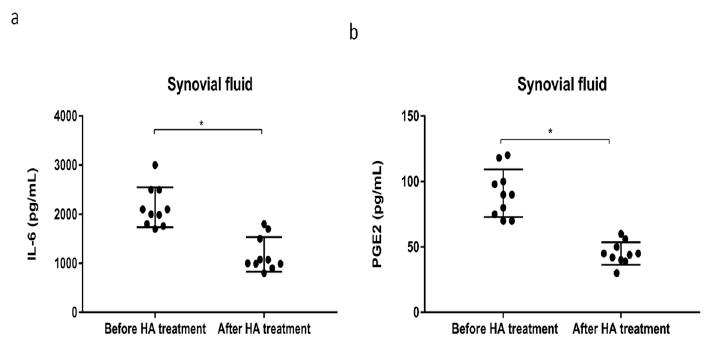
Figure 7. Effects of HMW-HA treatment on the inflammatory cytokines in the synovial fluid from OA patients. The inflammatory cytokines from the synovial fluid before and after HMW-HA treatment from 10 patients with OA: ( a , b ) ELISA analysis of IL-6 and PGE2. Data are expressed as a mean ± SD, * p < 0.05. The data presented are representative of three independent experiments.